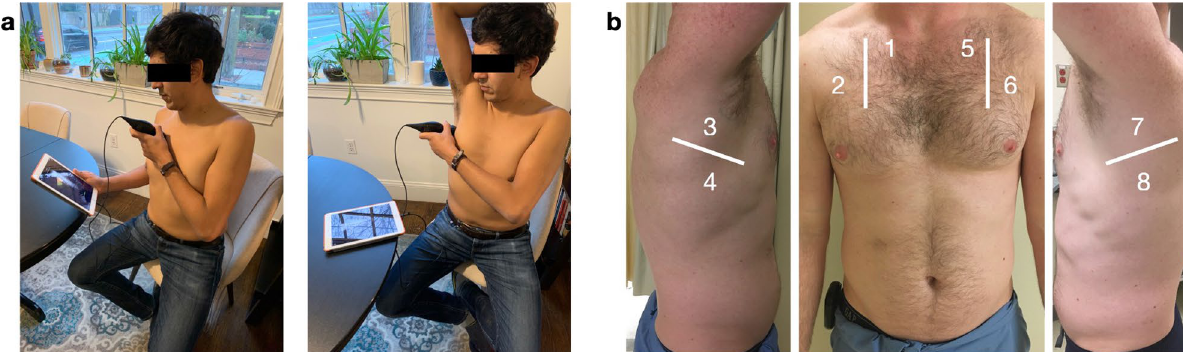
Figure 1. Novice-performed lung ultrasound scanning protocol. ( A ) A novice self-performs a LUS using a hand-held ultrasound probe attached to an iOS device. ( B ) 8-zone scanning protocol performed by both novices- and